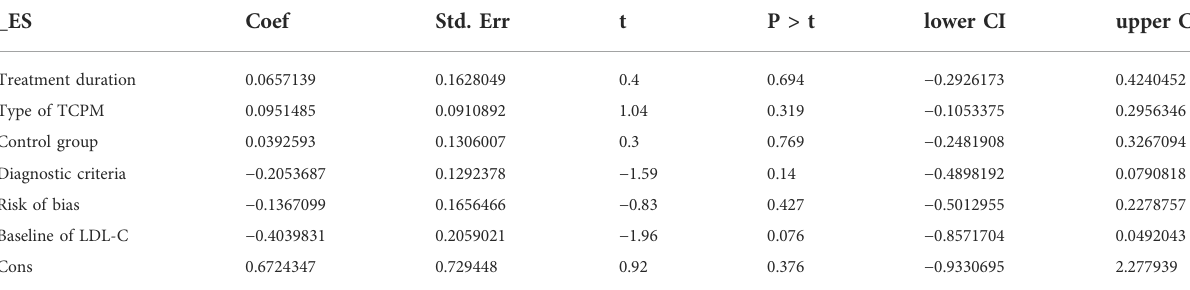
FIGURE 8 Sensitivity analysis of Δ LDL-C.